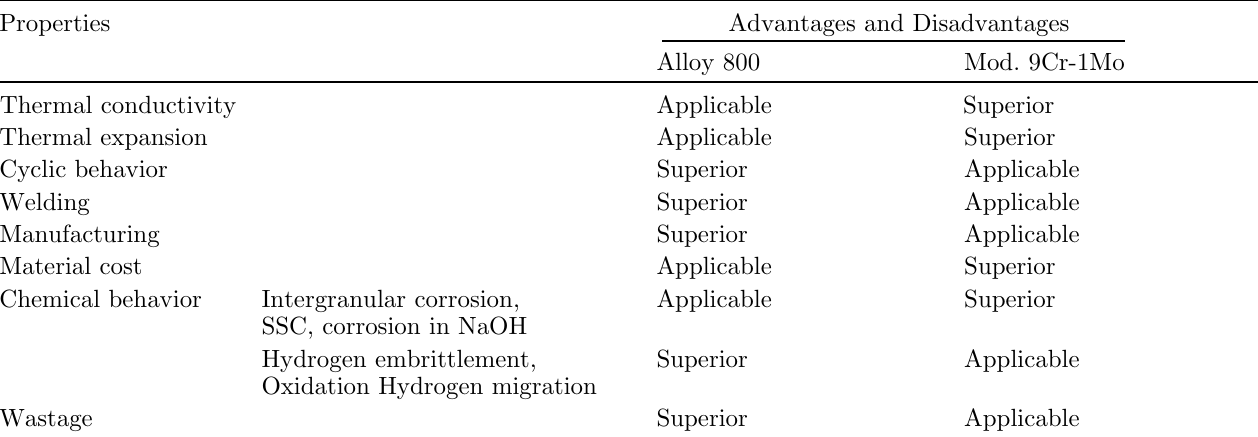
Table 2. Comparison between the cold and the warm roof slab